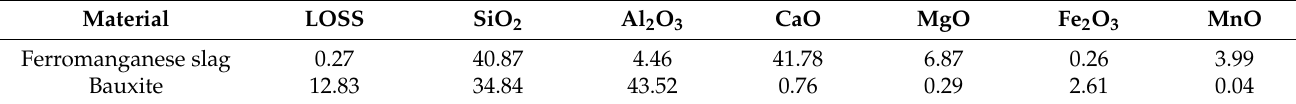
Table 1. Oxide composition of main materials (wt %).